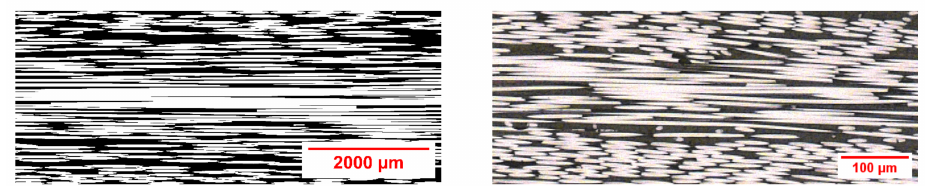
Figure 11. Geometric validation of virtually compressed geometry ( left ) with micrograph of UD- composite ( right ) (both images yarn with 30 t/m).